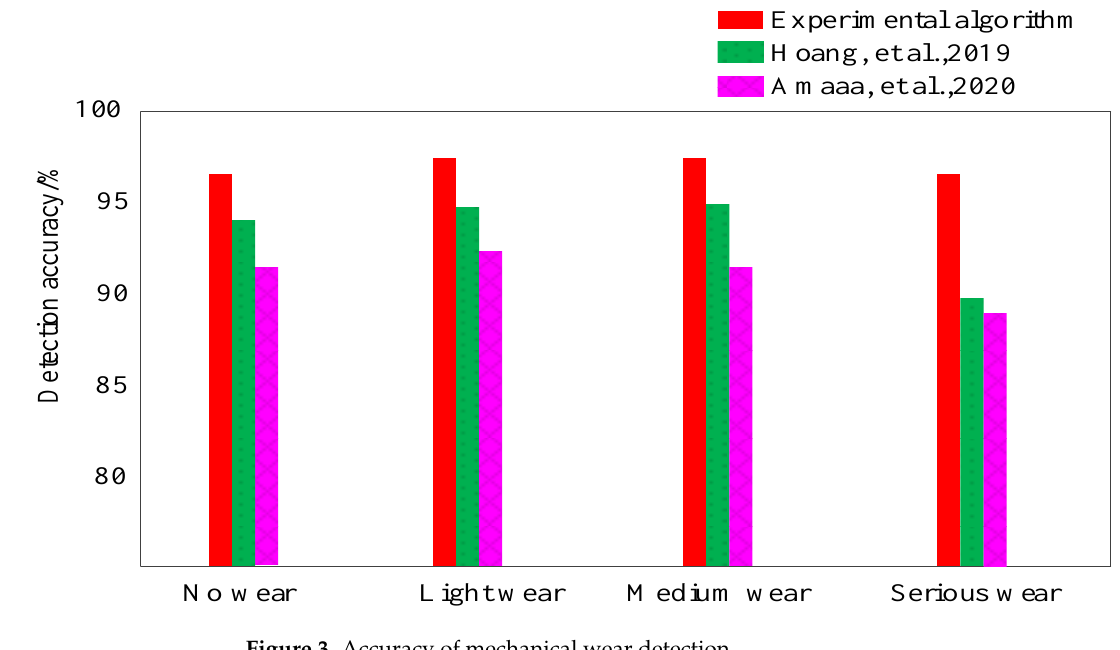
Figure 3. Accuracy of mechanical wear detection.